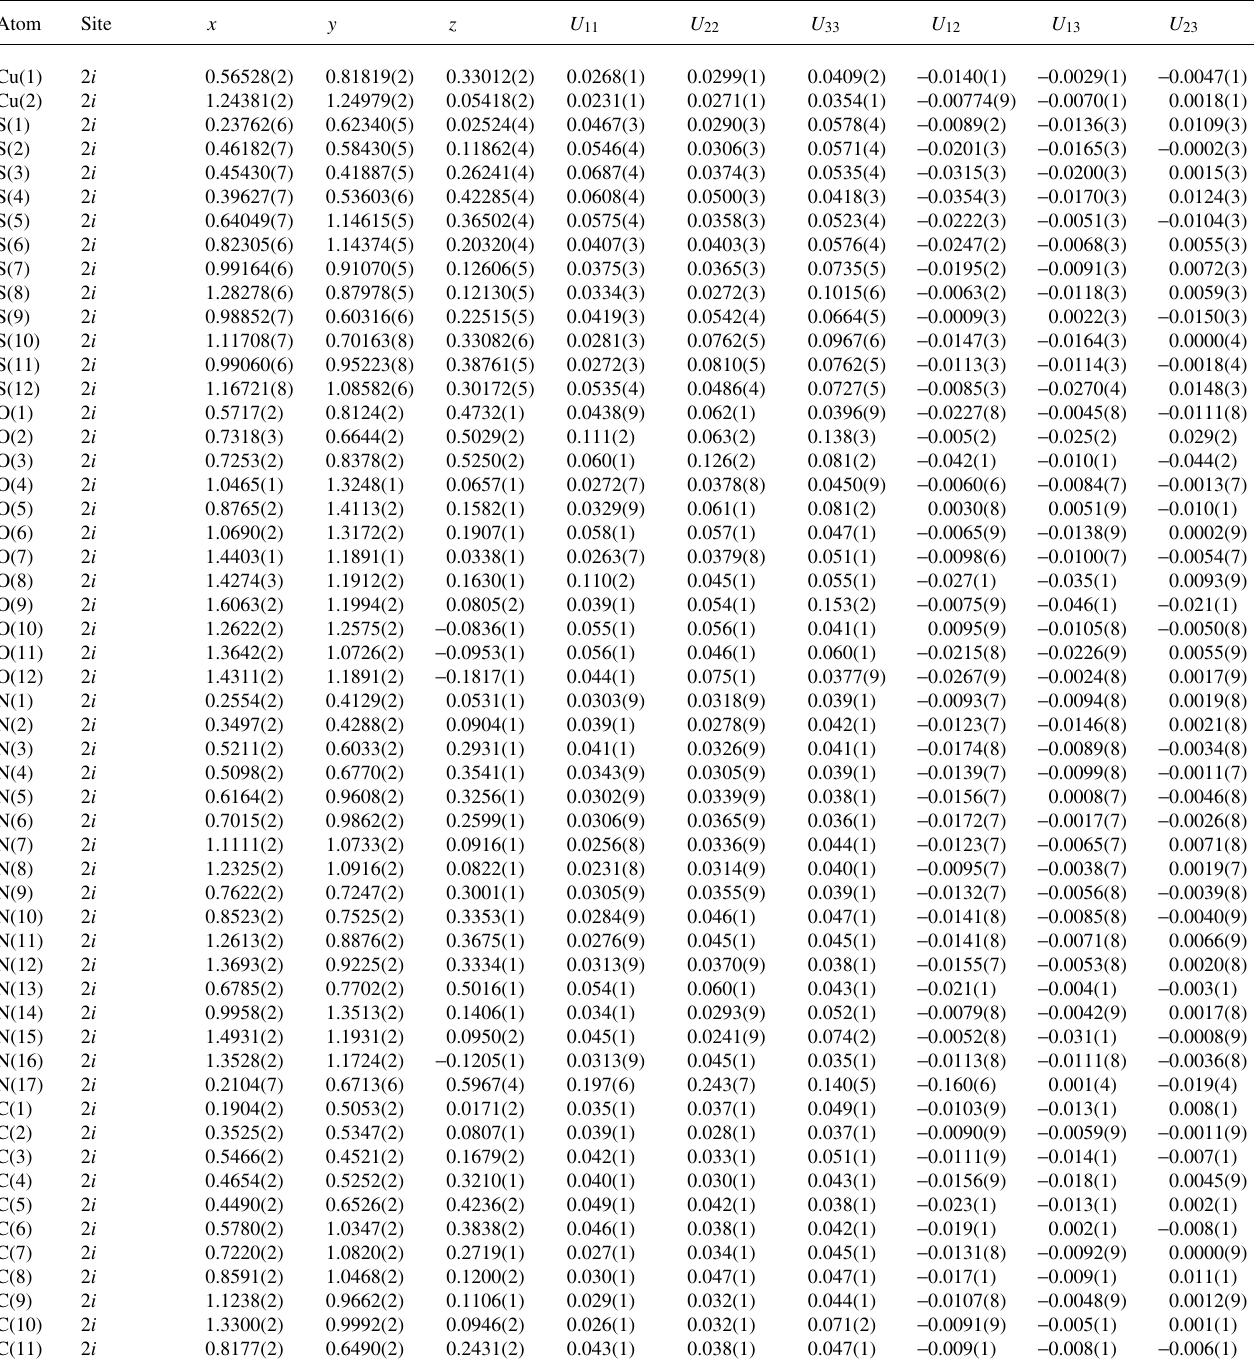
Table 3. Atomic coordinates and displacement parameters (in Å 2 ) .